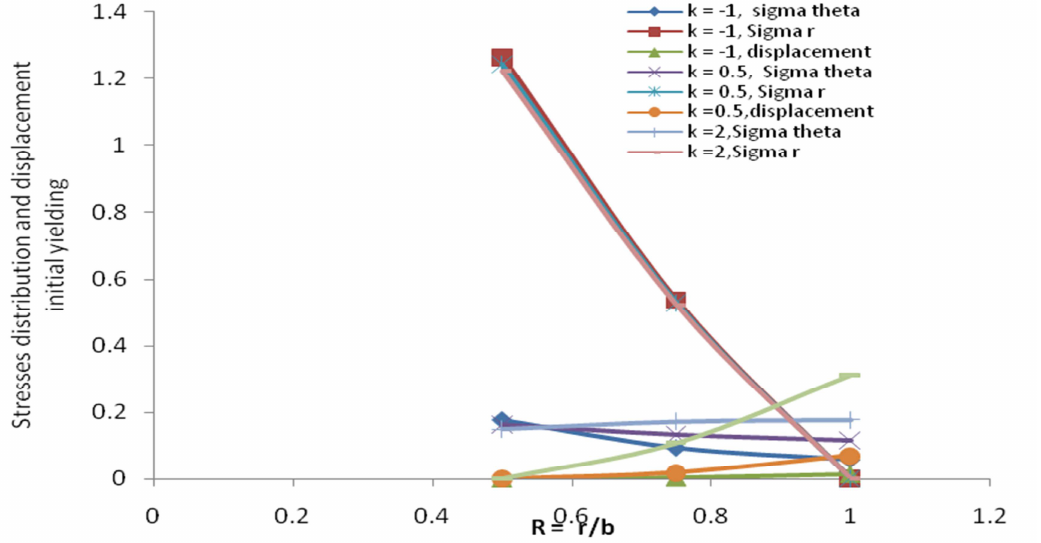
Figure 3. Stresses and Displacement at the elastic-plastic transition of rotating disc along the radius R =